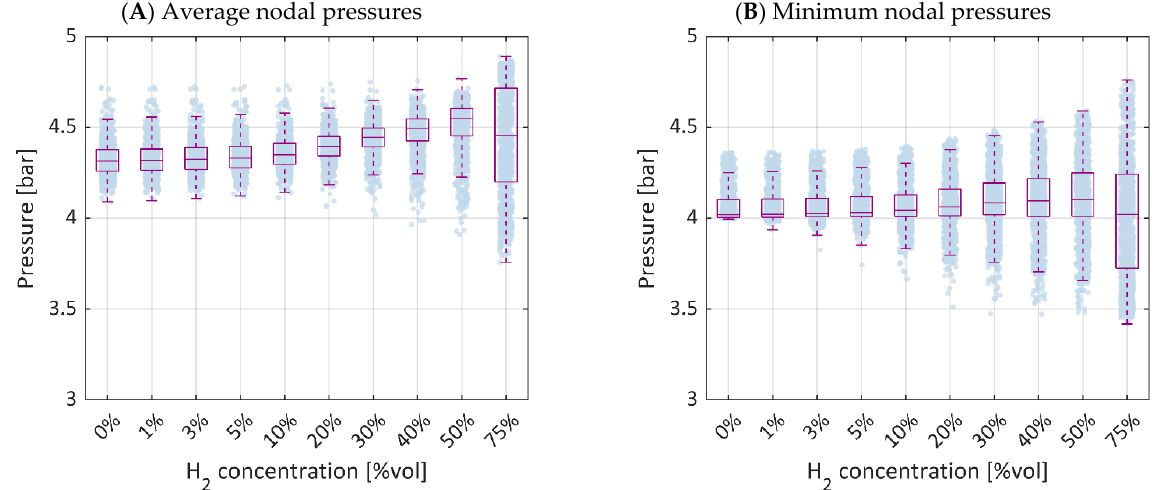
Figure 9. Evolution of average ( A ) and minimum ( B ) nodal pressures recorded in 1000 networks with increasing H 2 concentrations—pure H 2 injected within the network.